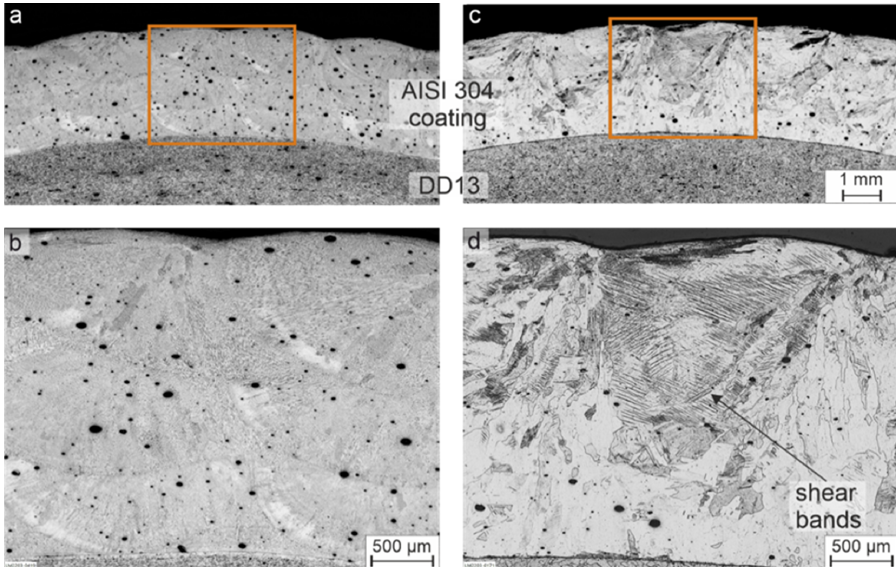
Figure 5. Cross sections of the samples after 3-point bending tests for ( a ) coating of AISI 304 in as-cladded condition with ( b ) higher magnification image, and ( c ) after heat treatment at 1100 °C for 60 min with ( d ) higher magnification image.